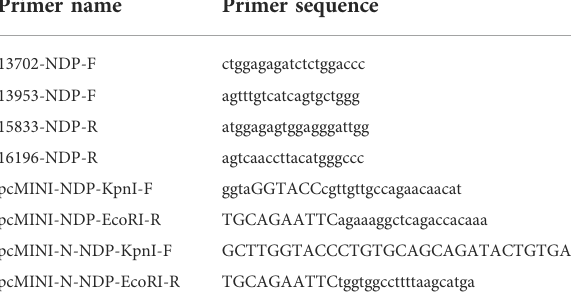
TABLE 1 The primer for sanger sequencing. TABLE 2 The ampli fi ed plasmid-speci fi c